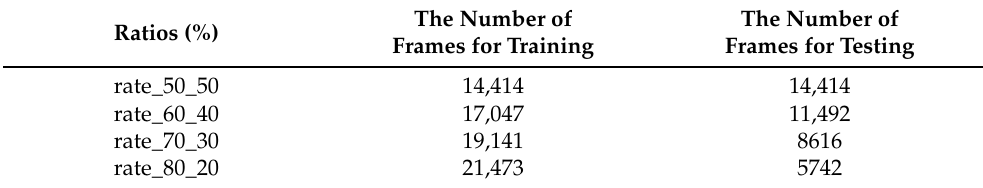
Table 8. The number of frames in the ratios (%—percent) for training and testing of MASK MADS dataset. The Number of The Number of Ratios (%) Frames for Training Frames for Testing rate_50_50 14,414 14,414 rate_60_40 17,047 11,492 19,141 8616 21,473 5742